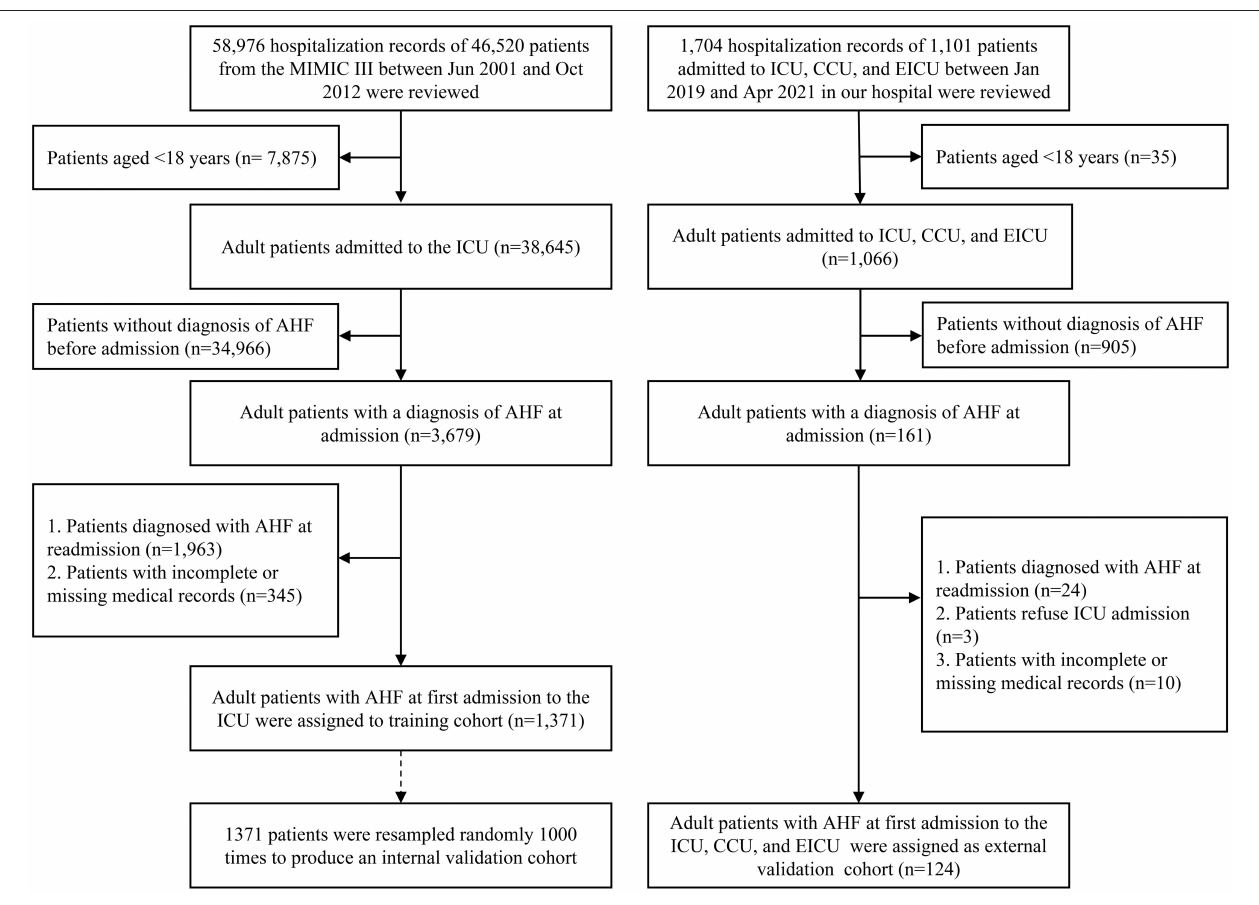
FIGURE 1 | The patient selection process for this study. AHF, acute heart failure; ICU, intensive care unit; CCU, coronary care unit; EICU, emergency ICU.